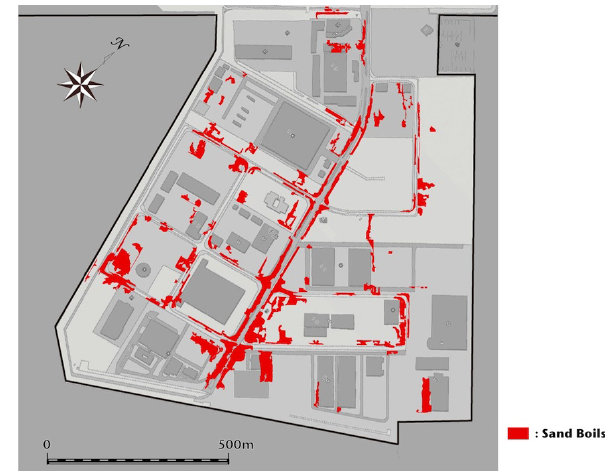
Figure 5. Distribution of sand boils in Chidori block, Urayasu City (RIEGC,